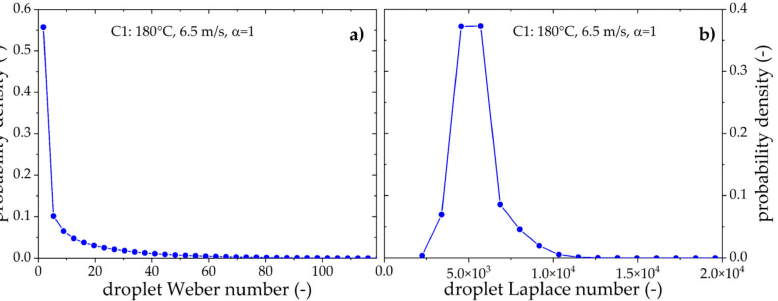
Figure 14. Distribution of impinging droplets: ( a ) Weber number and ( b ) Laplace number.